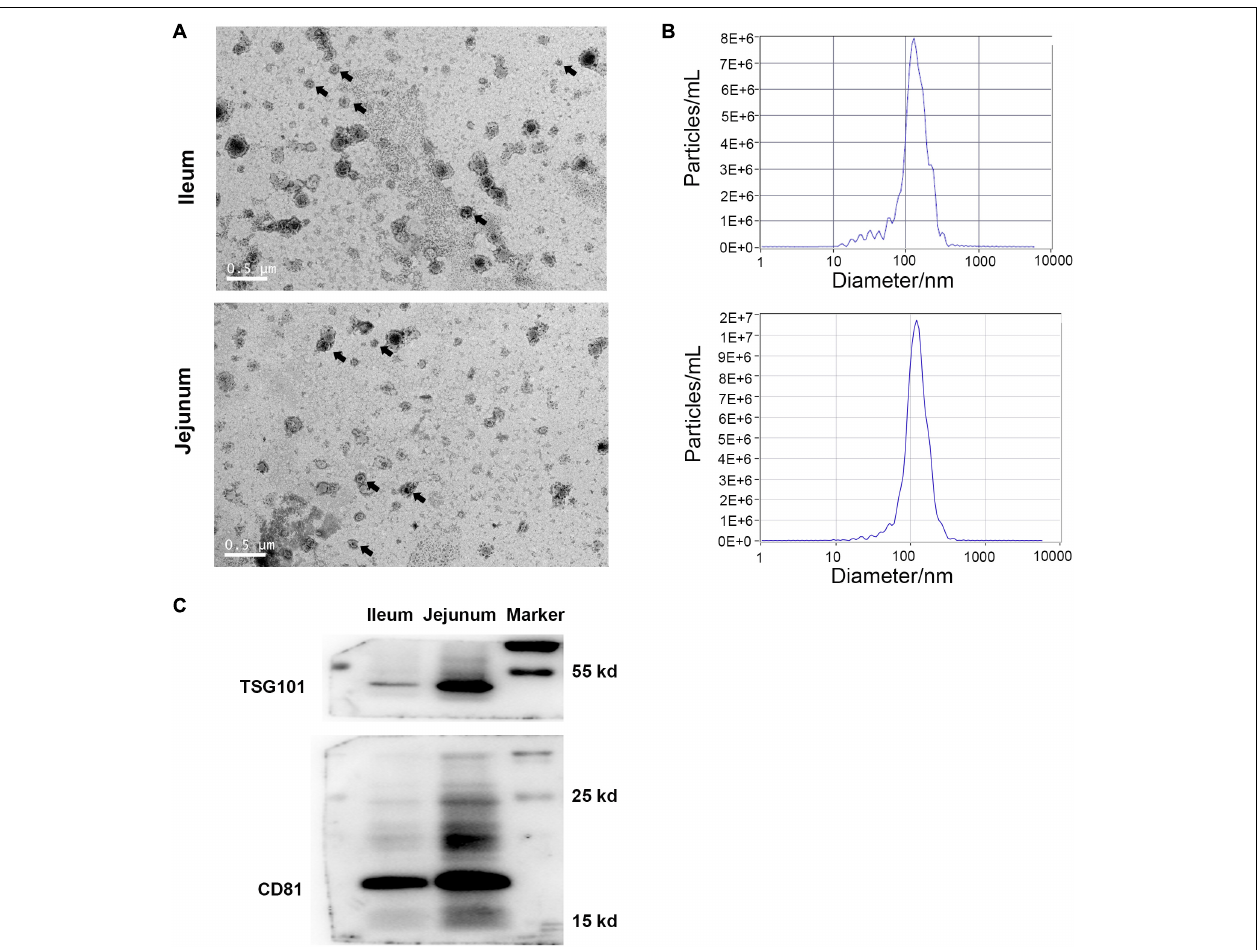
FIGURE 1 | Identification of IEC-Exos from ileum and jejunum. (A) Transmission electron microscopic observation (scale = 0.5 µ m), arrows indicated the typical exosomes. (B) Nanoparticle tracking analyzer Size Distribution. (C) Immunoblot of CD81 and TSG101 in